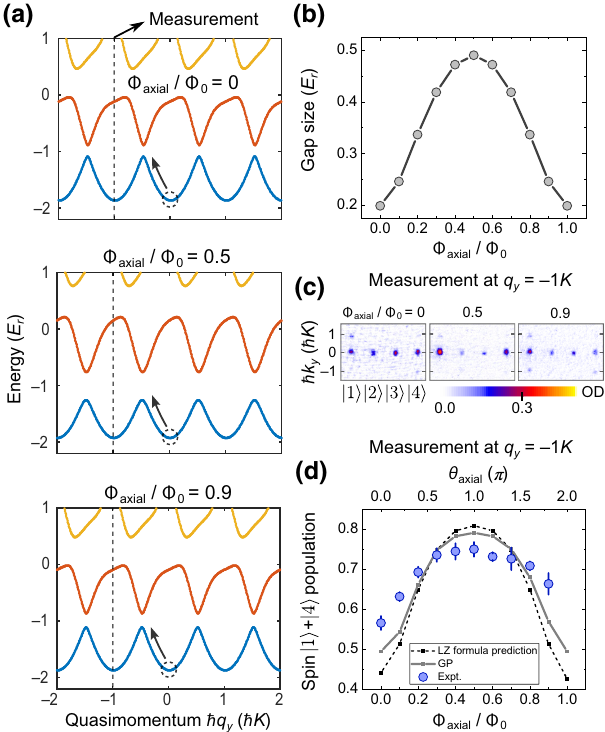
FIG. 4. Effects of the synthetic axial magnetic flux (cid:9) axial on band structures and transport. (a) Band structures calculated using similar parameters to those for Fig. 2(b) with additional rf couplings (cid:2) rf1(rf2) = 0.8 ( − 1.1 ) E r at representative values of = − 1 K (at (cid:9) axial . We focus on transport measurement at q y t hold = 1.3 ms, indicated by dashed lines) for a BEC initially prepared around q y = 0 (dashed circles). (b) Calculated band gap size between the two lowest bands at various (cid:9) axial . (c) Select TOF images measured at q y = − 1 K with representative values of (cid:9) axial . (d) Spin population versus (cid:9) axial measured at q y = − 1 K , compared with GP simulations (solid line) and the prediction (dashed line) by the Landau-Zener formula; see the